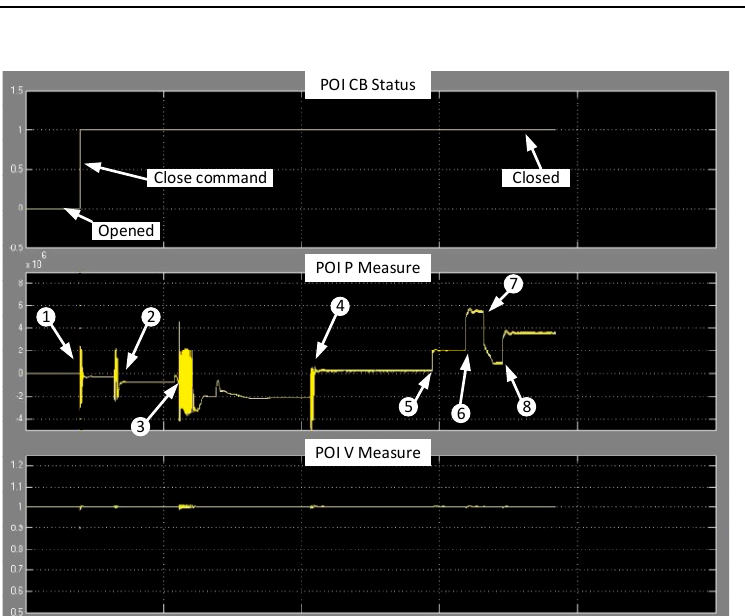
Table 3. Validation of F-FDIR. 1